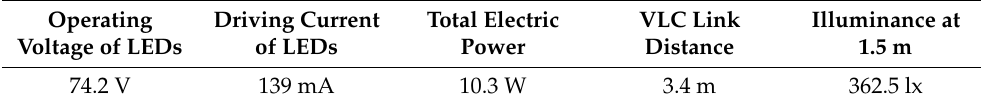
Table 3. Measured working state of proposed VLC lightbulb.